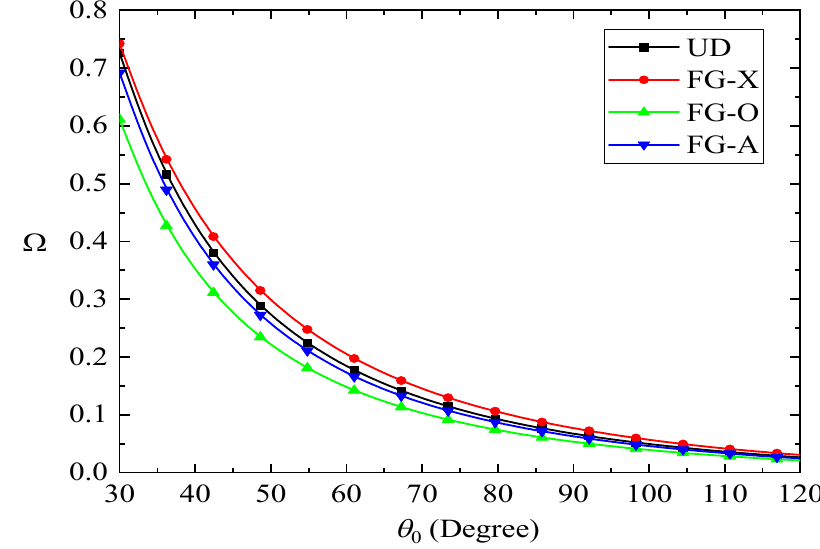
Figure 9. The fundamental frequency of S-S FG-GPLRC thick circular arch ( λ = 1 / 5) against the subtended angle θ 0 .